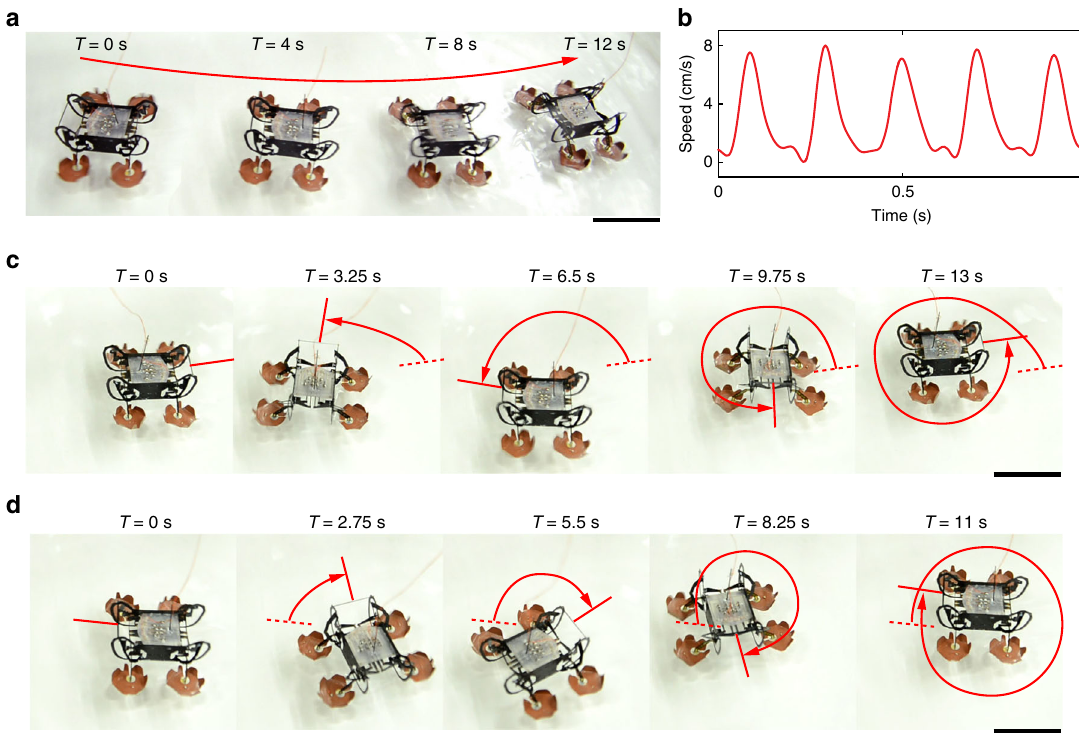
Fig. 5 Robot swimming and turning on the water surface. a The robot moves on the water surface at 2.8 cm s -1 with a 5 Hz swimming gait. b The robot ’ s instantaneous swimming speed tracked using a high-speed video (Supplementary Movie 3). c The robot makes a complete left turn on the water surface in 13 seconds. d The robot makes a complete right turn on the water surface in 11 seconds. Scale bars ( a , c , d ), 2 cm. These demonstrations show that the robot can controllably move on the surface of